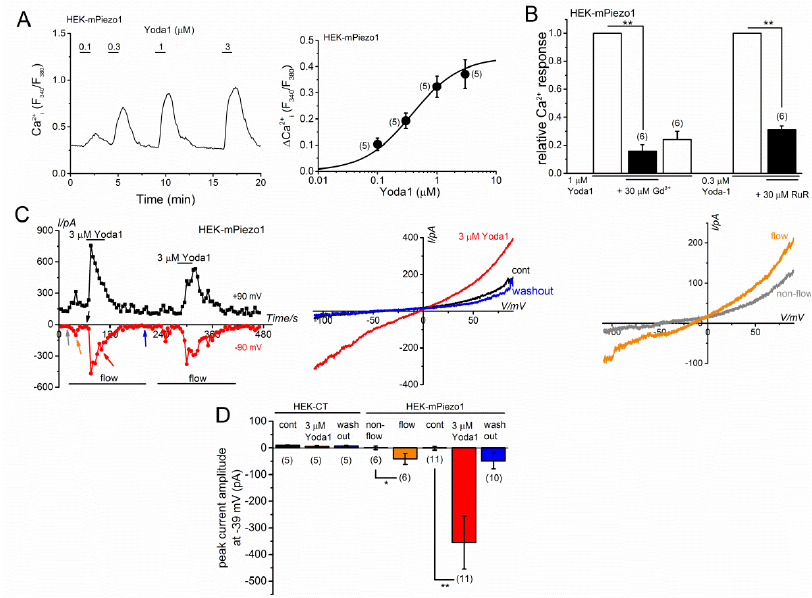
Figure 2. Yoda1-induced response in HEK-mPiezo1 cells. ( A ) A representative Ca 2+ response of HEK-mPiezo1 cells to Yoda1 at a concentration ranging from 0.1 to 3 µ M (left panel). The peak